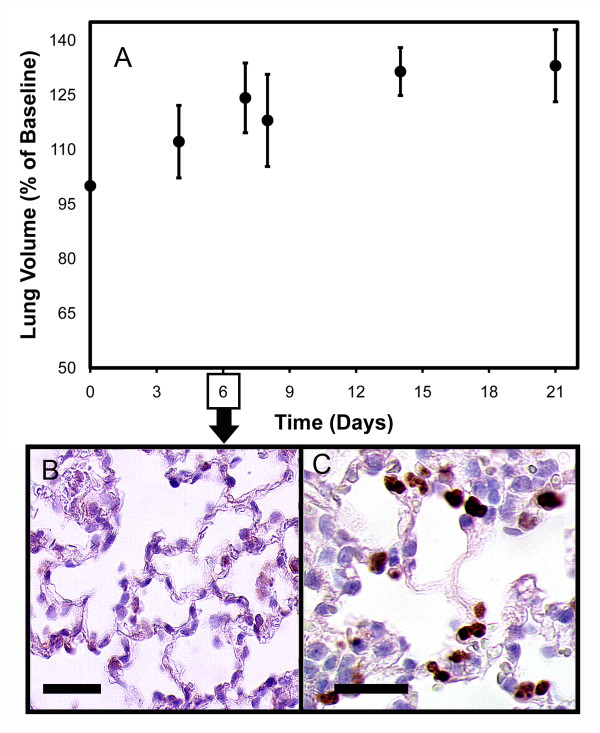
Functional and histologic evidence of compensatory lung growth after pneumonectomy (Day 0). A) Lung volumes obtained by a FlexiVent maximal vital capacity maneuver (named TLC by SCIREQ). The mouse was allowed to exhale to residual volume then ventilated with a 3 sec ramp to a 3 sec plateau at 30 cmH2O pressure. The measured volume was expressed as a percent of Day 0 post-pneumonectomy baseline. Each data point reflects the mean of N = 3 mice ± 1 SD; 3 TLC maneuvers per mouse. B) Control and C) Ki-67 (Clone TEC-3, Dako, Hamburg, Germany) immunohistochemistry of the lung during the "growth" phase (Day 6) demonstrated scattered positive cells providing evidence of proliferation within the alveolar septa (arrow, bar = 25 um).